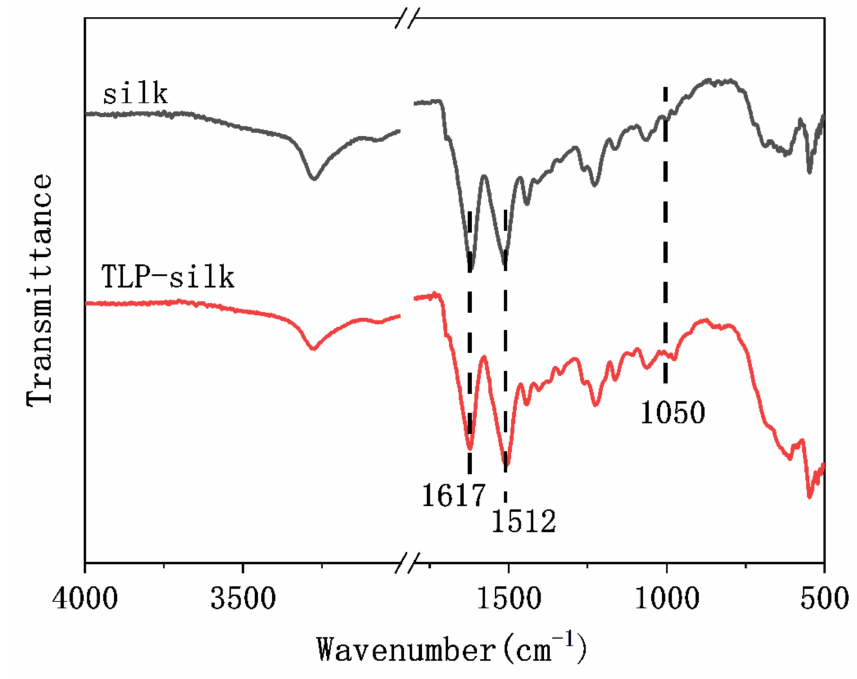
Figure 4. FTIR spectra of control and TLP-finished silk fabrics. Table 2. Washability of finished fabric.